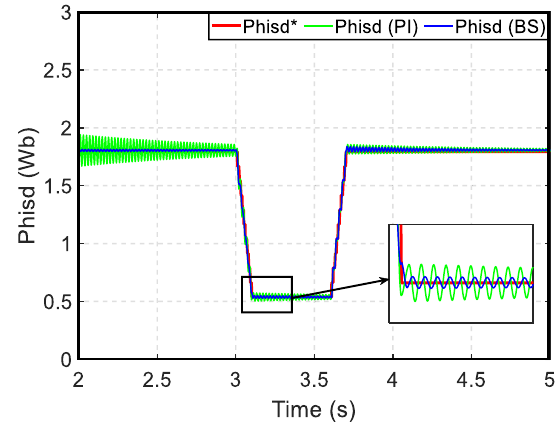
Fig. 15 Evolution of the mechanical speed